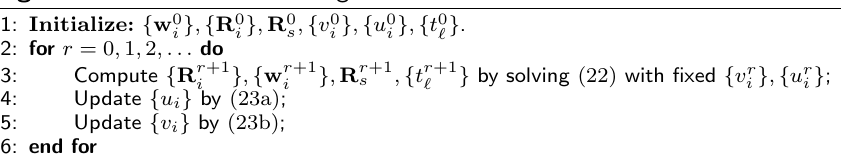
Algorithm 1 WMMSE-SDR